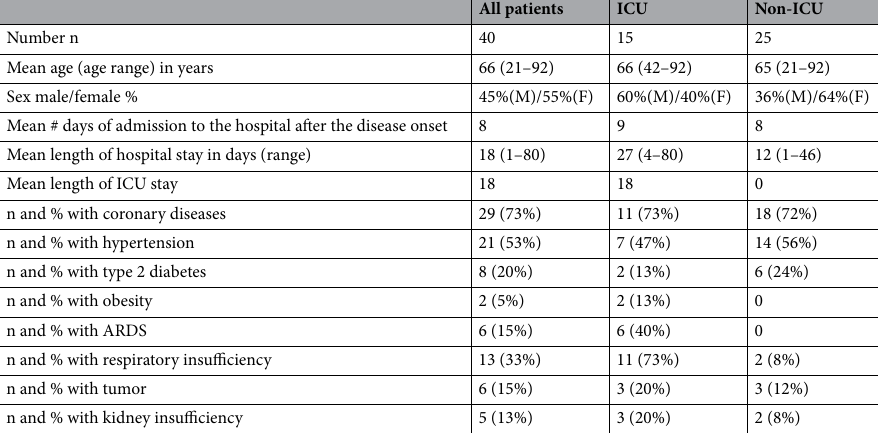
Table 1. Main characteristics of the patients and their